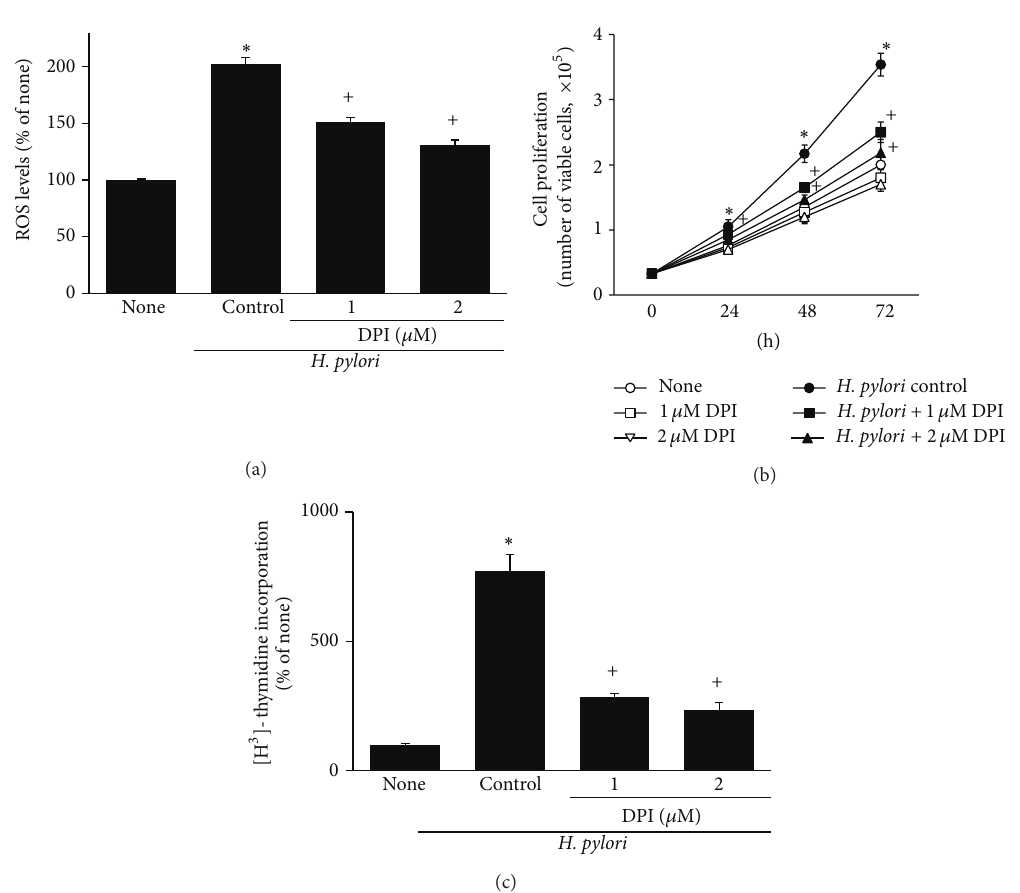
Figure 7: Effect of DPI on ROS levels and cell proliferation of H. pylori- infected AGS cells. The cells were pretreated with DPI for 2 h and cultured in the presence or absence of H. pylori. (a) ROS levels were determined by DCF fluorescence after 30 min of H. pylori infection. The levels of ROS trapped in the cells treated without DPI and cultured in the absence of H. pylori are considered as 100%. (b) Viable cell numbers were determined by trypan blue exclusion assay for the indicated time period. (c) The cells were treated with [ 3 H ] thymidine at 24 h after H. pylori infection and incubated for 8h. The amount of [ 3 H ] thymidine incorporation of AGS cells cultured in the absence of H. pylori is considered as 100%. ∗ 𝑃 < 0.05 versus corresponding none (the cells cultured in the absence of H. pylori ); + 𝑃 < 0.05 versus corresponding H. pylori control (the cells cultured in the presence of H. pylori and treated without DPI).